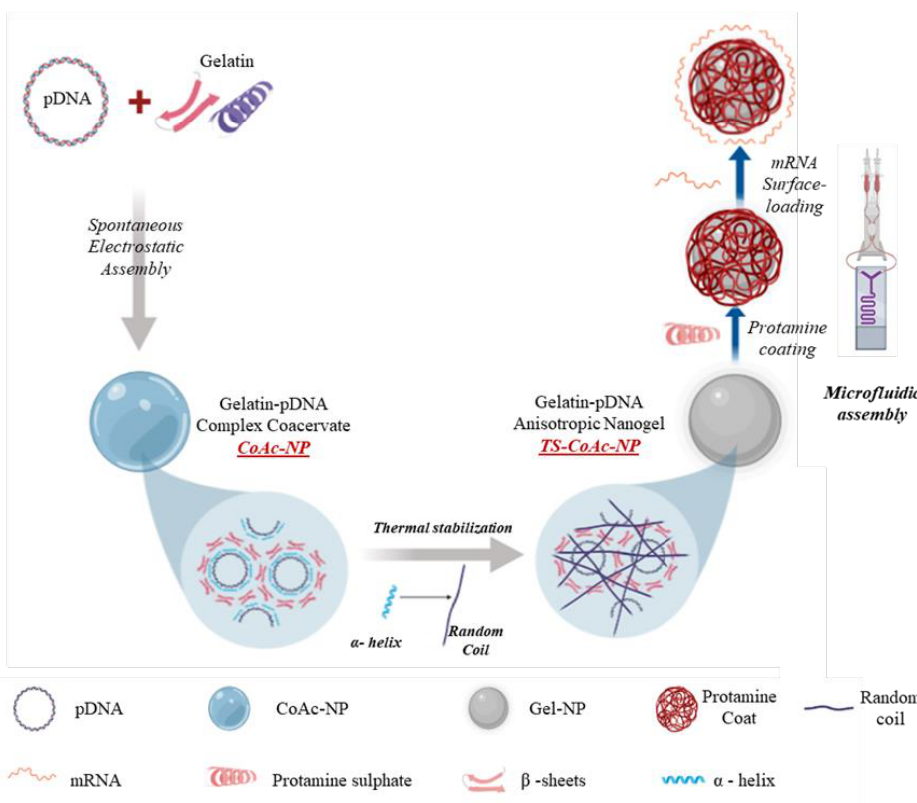
Figure 1. The general preparation procedure of CoAc, TS-CoAc, and P-TS-CoAc, and the proposed mechanism of thermal stabilization of CoAc into TS-CoAc. P-CoAc was prepared by the introduction of CoAc and protamine sulfate into a microfluidic coating system while skipping the thermal stabilization step of CoAc. Table 1. Composition and nomenclature of different formulations.